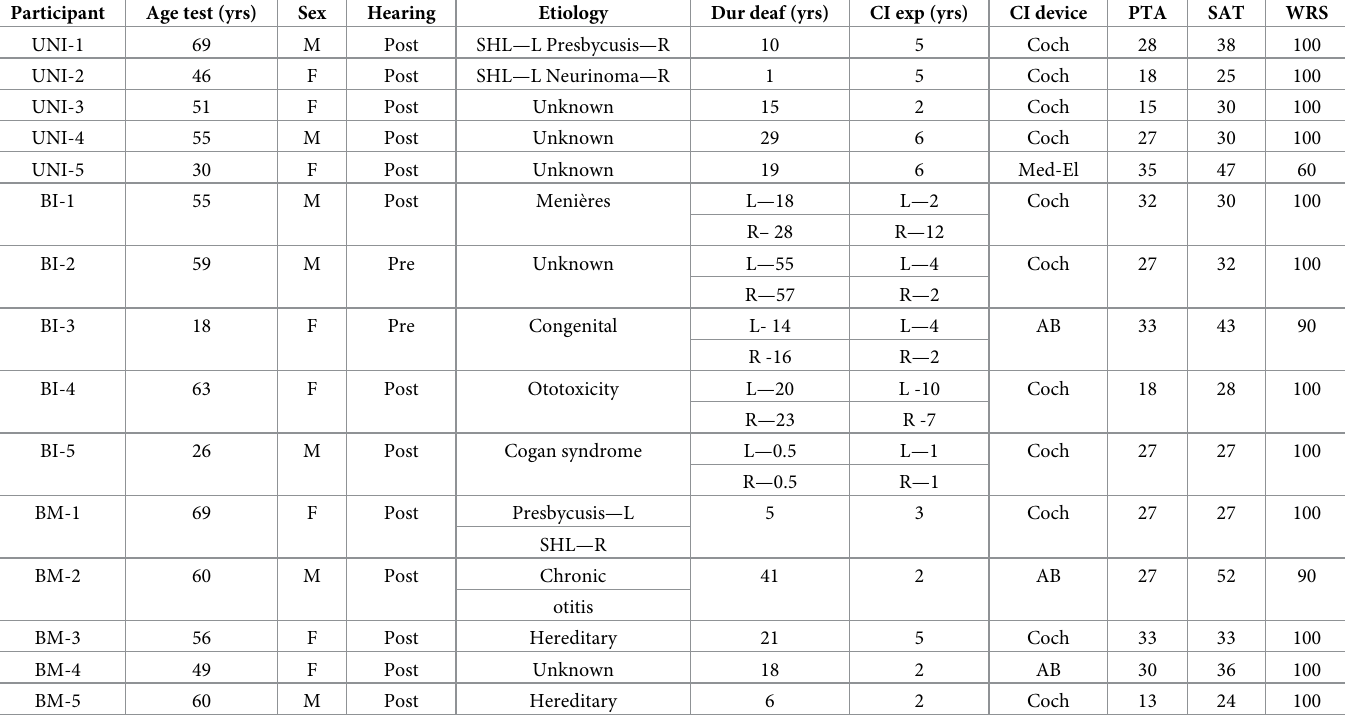
Table 1. Demographic information for the 15 CI